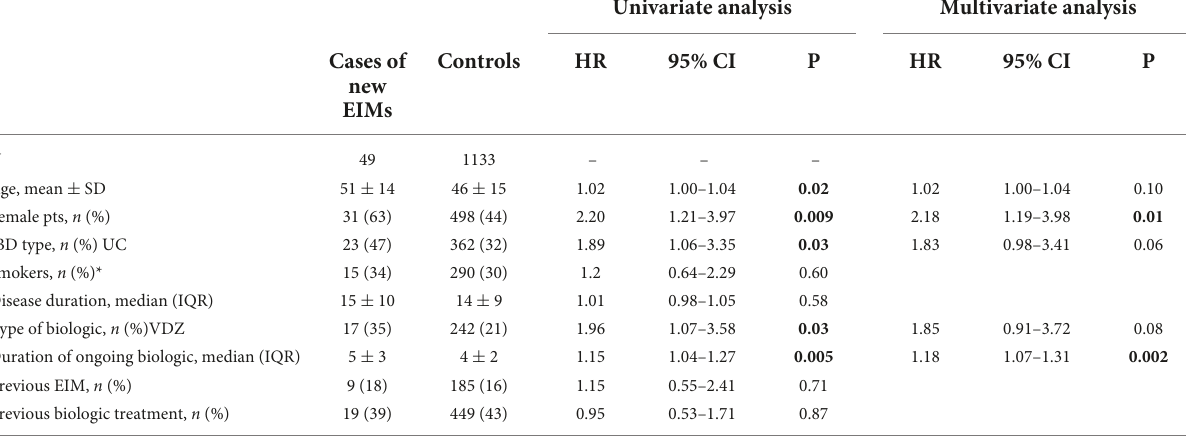
TABLE 2 The univariate and multivariate analysis of clinical variables predicting the new onset of extra-intestinal manifestations (EIMs) in our cohort of patients with inflammatory bowel disease (IBD). Univariate analysis Multivariate